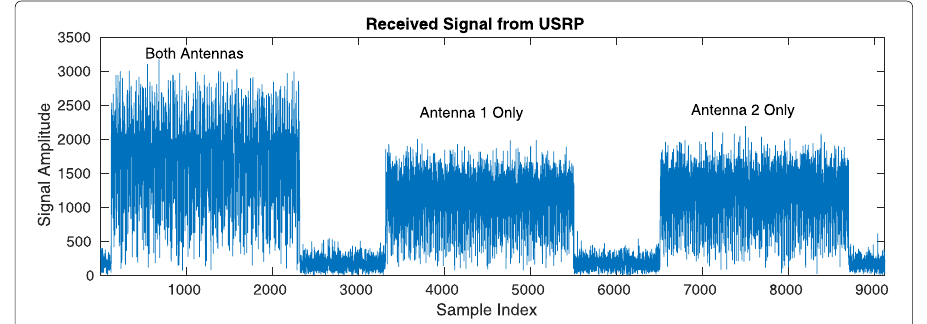
Fig. 5 The received time-domain signal in the